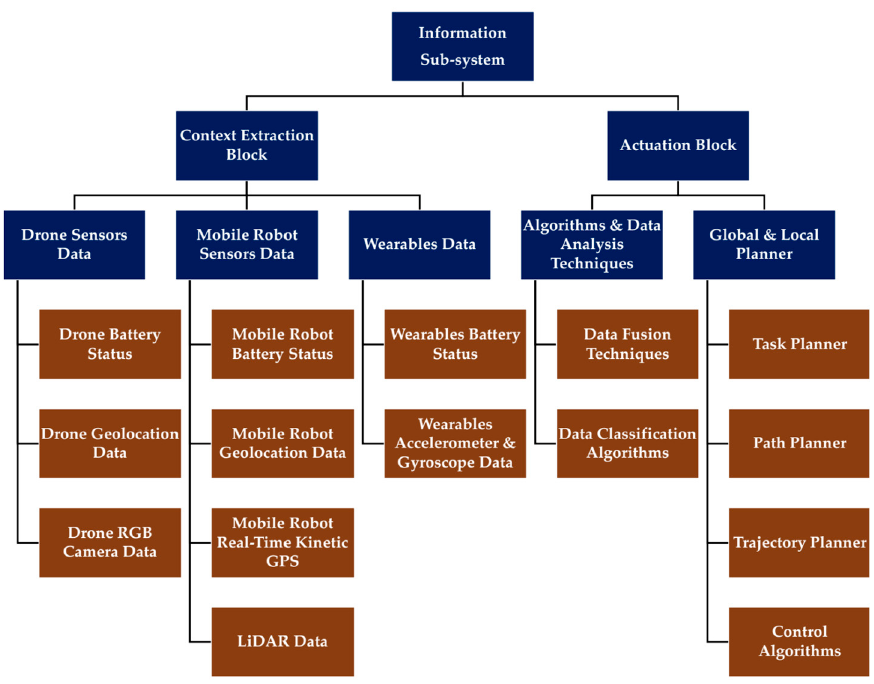
8 of 13 Figure 4. Operations scenario of the human–robot synergy system.